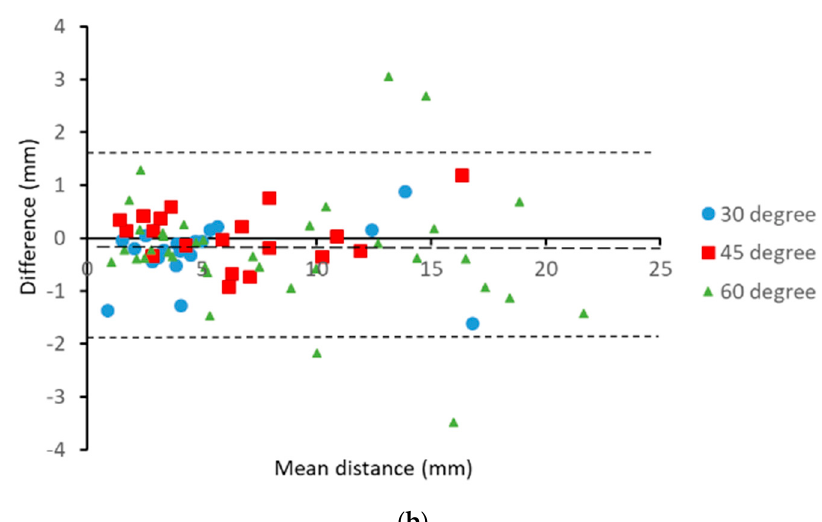
Figure 10. ( a ) Relationship between the B-mode and Doppler measurements and ( b ) Bland-Altman plot of the difference between the Doppler and B-mode measurements against the mean of the distance from both modalities.